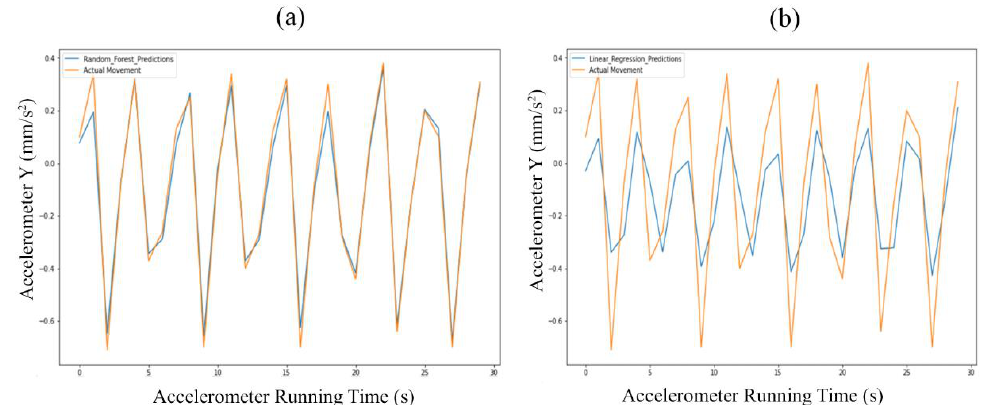
Figure 10. Data prediction in normal conditions using ( a ) RF regression method, ( b ) LR regression method.